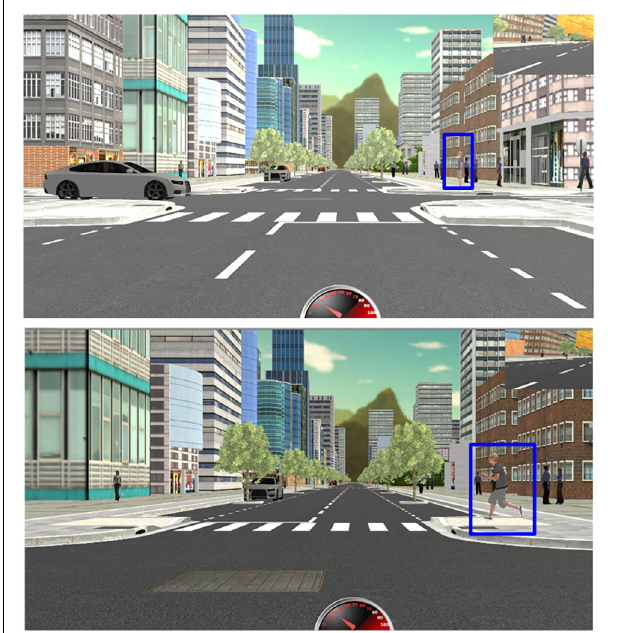
FIGURE 1 | Screenshots of a critical event (Scenario 2) at a four-way intersection viewed from the perspective of the driver (only the view on the center monitor is shown). Top —when the driver approached the intersection, a gray car approached the intersection from the left side, and a pedestrian (marked with a blue rectangle) was standing on the right on the far side of the intersection. Bottom —when the driver entered the intersection, the pedestrian started running across the road at the zebra-marked crosswalk, requiring the driver to brake to avoid a collision.